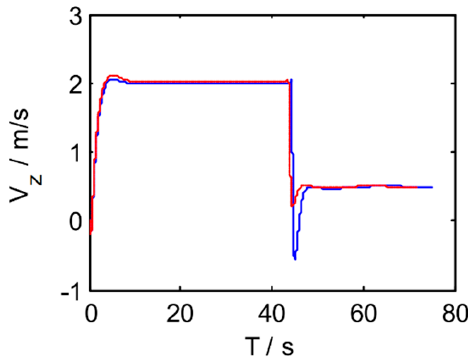
Figure 8. Landing speed in windless conditions.